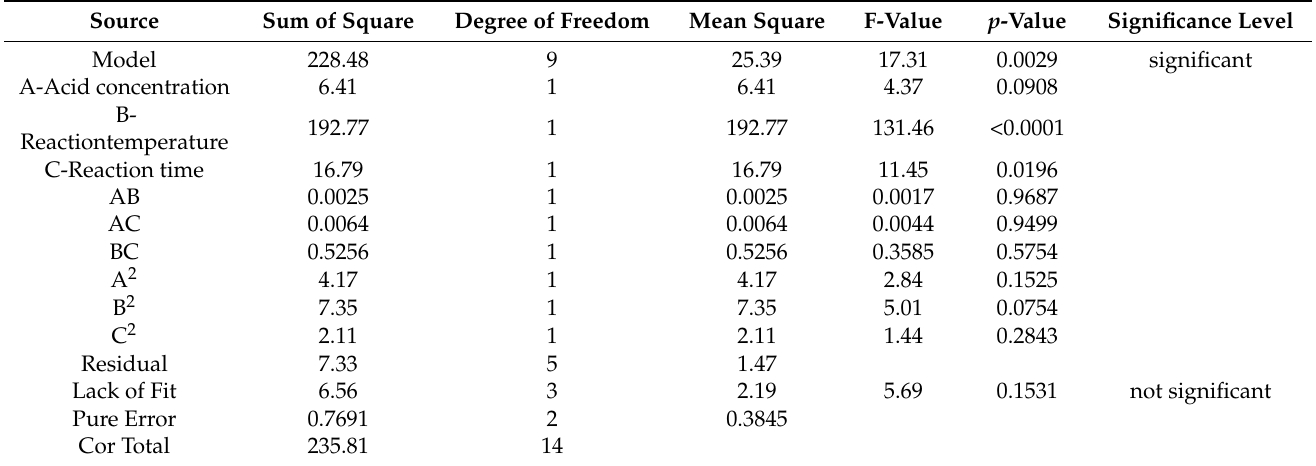
Table 5. ANOVA for the response surface quadratic